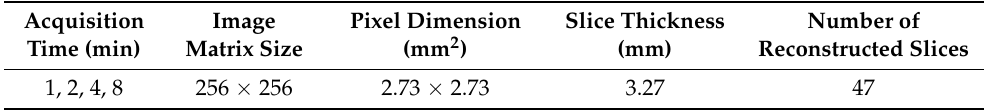
Table 2. Acquisition parameters for the phantom acquisitions.